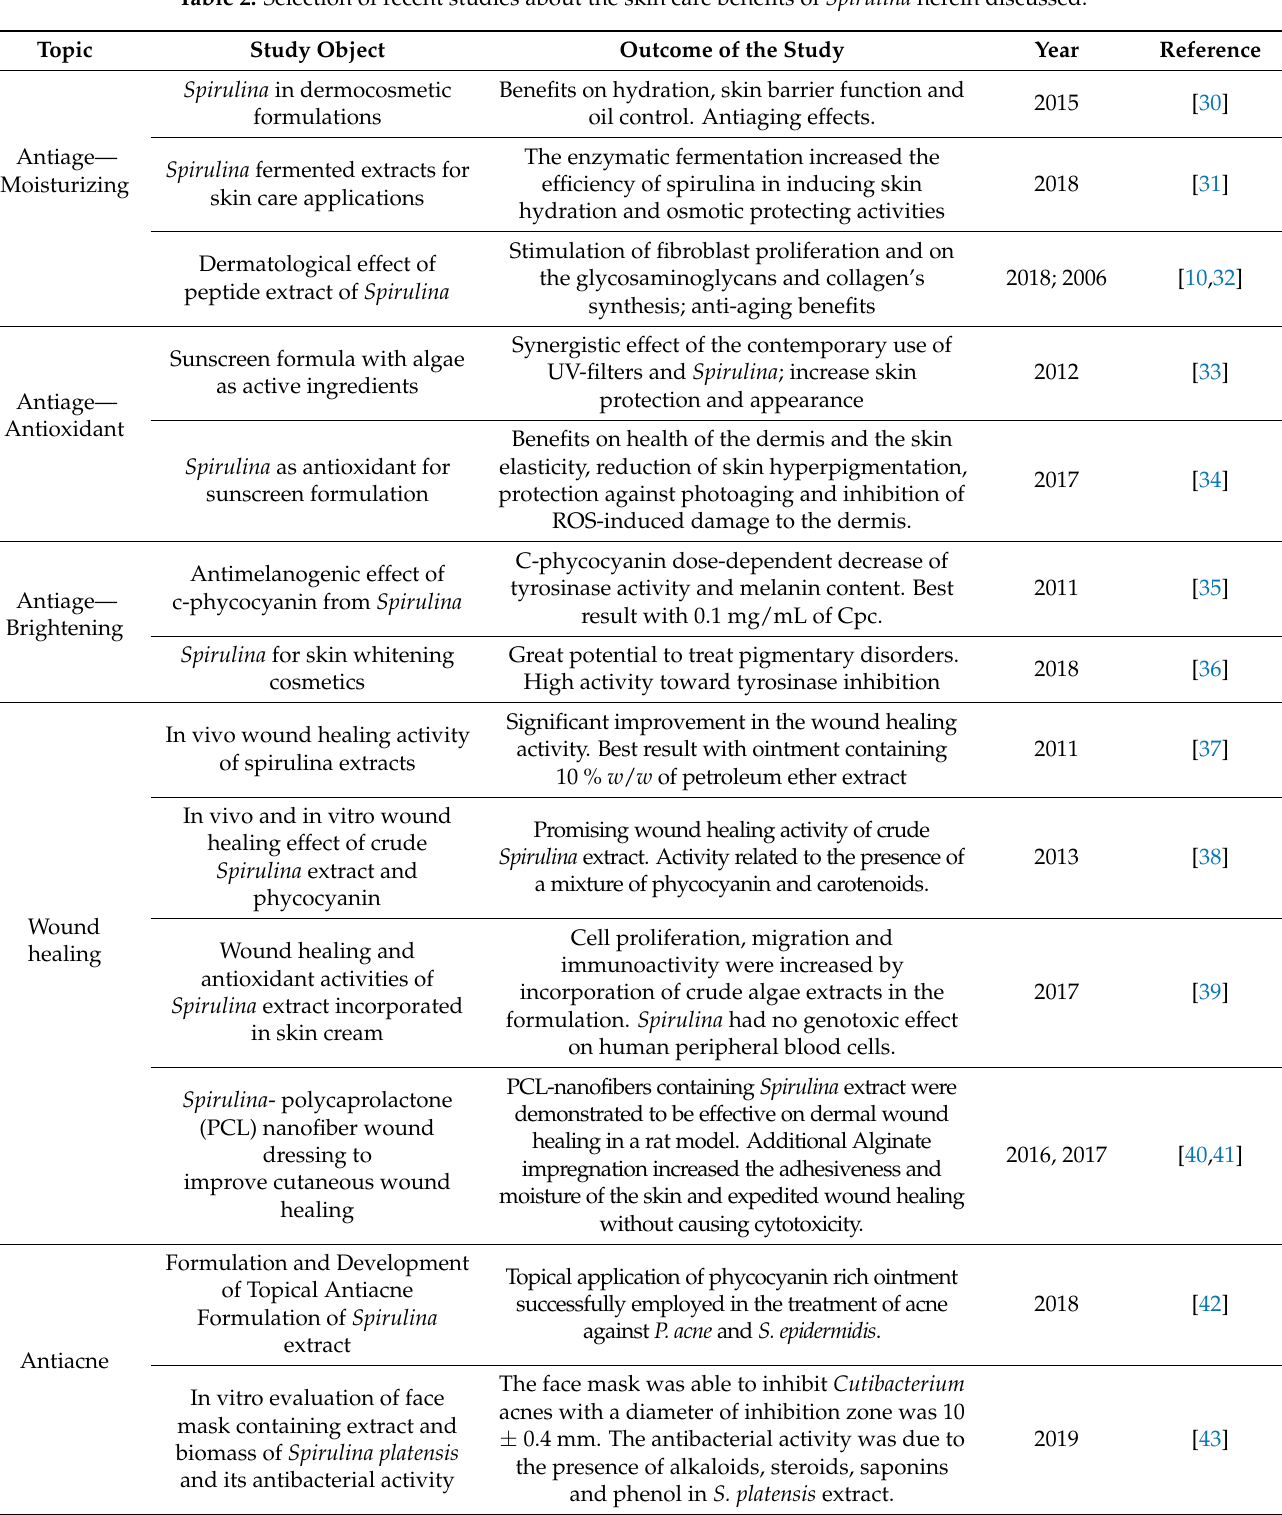
Table 2. Selection of recent studies about the skin care benefits of Spirulina herein discussed. Topic Study Object Outcome of the